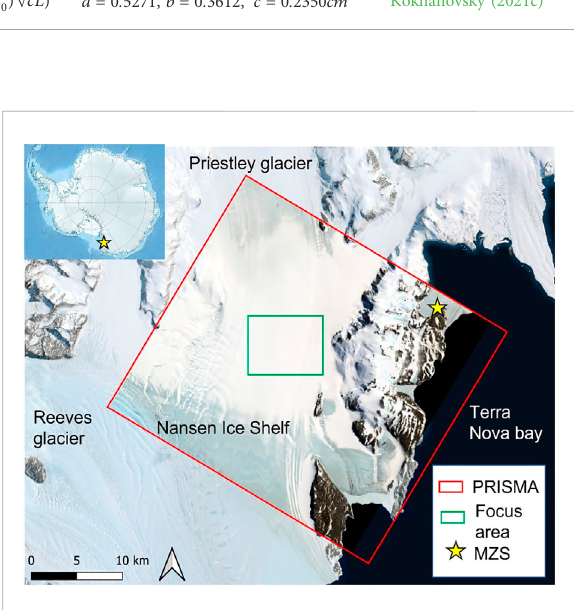
FIGURE 1 Browse image of the study area in the Nansen Ice Shelf (East Antarctica). PRISMA image (red rectangle) was acquired on 4 December 2020; 21:35UTC. The focus area where we applied the retrieval method is also represented (green rectangle). The yellow star marks the location of the Italian Antarctic base Mario Zucchelli Station (MZS). The coordinates of the green box are: lower - right corner: 74 ° 45 ′ 25.81 ″ S 163 ° 39 ′ 9.54 ″ E, upper - left corner: 74 ° 42 ′ 4.6 ″ S 163 ° 24 ′ 46.51 ″